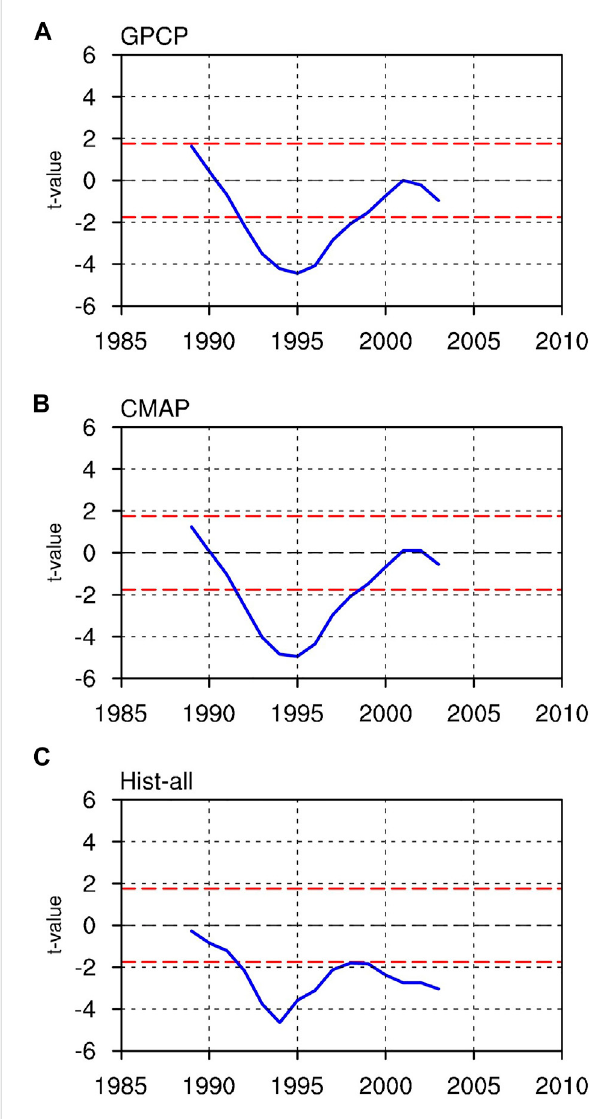
FIGURE 7 The moving Student ’ s t -test of the area-mean precipitation anomalies over Southeast Asia, as illustrated in Figure 6A, with a 9-year window in (A) GPCP, (B) CMAP, and (C) Hist-all MME, respectively. The dashed red lines indicate the 90% con fi dence levels based on the two-tailed Student ’ s t -test.